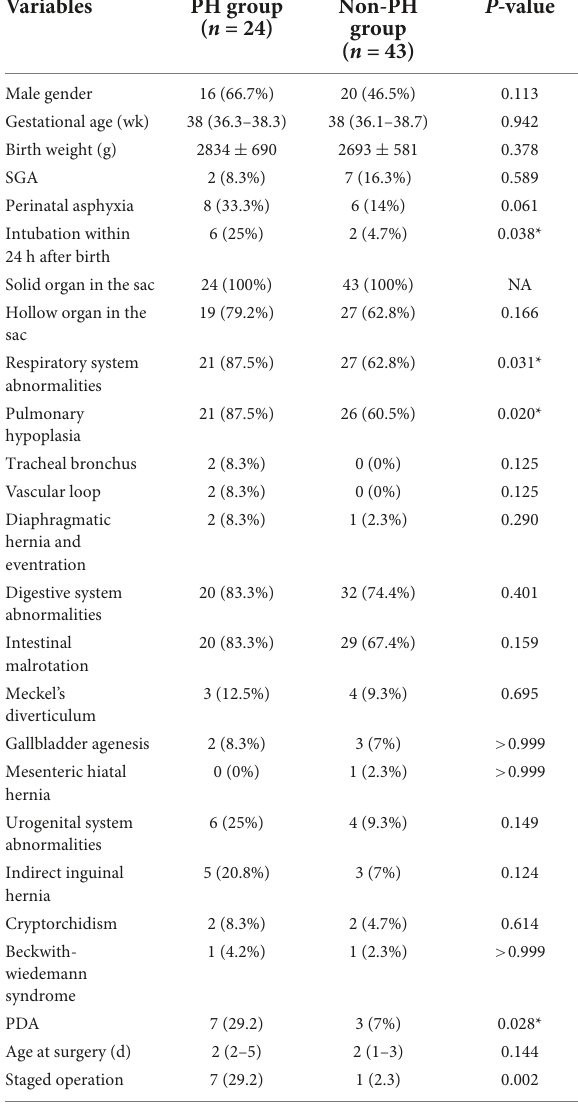
TABLE 1 Comparison of the baseline characteristics of the study cohort by the presence of PH.